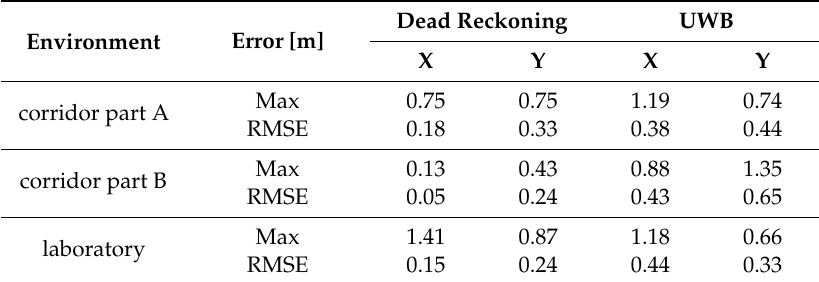
Table 2. The positioning errors using di ff erent methods.